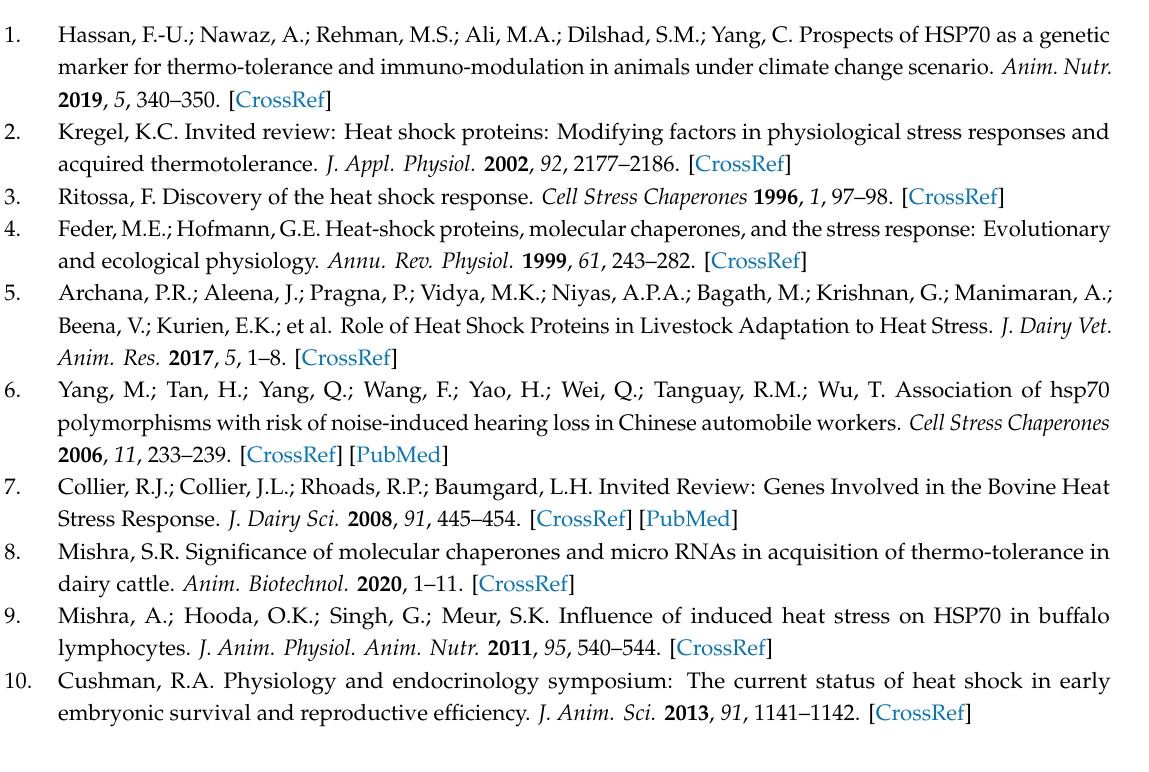
Figure S1: Tree with alignment view of HSP40 . Percentage of sequence is represented with di ff erent colors in Identity bar at top of the sequences green color indicates 100% identity, green-brown shows at least 30 and under 100% while red representing below 30 identity. Figure S2: Tree with alignment view of HSP70 . Percentage of sequence is represented with di ff erent colors in Identity bar at top of the sequences green color indicates 100% identity, green-brown shows at least 30 and under 100% while red representing below 30 identity. Figure S3: Tree with alignment view of HSP90 . Percentage of sequence is represented with di ff erent colors in Identity bar at top of the sequences green color indicates 100% identity, green-brown shows at least 30 and under 100% while red representing below 30 identity. Figure S4: Tree with alignment view of HSPD . Percentage of sequence is represented with di ff erent colors in Identity bar at top of the sequences green color indicates 100% identity, green-brown shows at least 30 and under 100% while red representing below 30 identity. Figure S5: Tree with alignment view of HSP10 . Percentage of sequence is represented with di ff erent colors in Identity bar at top of the sequences green color indicates 100% identity, green-brown shows at least 30 and under 100% while red representing below 30 identity. Figure S6: Tree with alignment view of HSPH1 . Percentage of sequence is represented with di ff erent colors in Identity bar at top of the sequences green color indicates 100% identity, green-brown shows at least 30 and under 100% while red representing below 30 identity. Figure S7: Tree with alignment view of HSPB . Percentage of sequence is represented with di ff erent colors in Identity bar at top of the sequences green color indicates 100% identity, green-brown shows at least 30 and under 100% while red representing below 30 identity. Table S1: Accession no. of di ff erent heat-shock protein in di ff erent organisms used in phylogenetic analysis, Table S2: Accession no. of bu ff alo HSP90 , Table S3: Accession no. of bu ff alo HSP70 , Table S4: Accession no. of bu ff alo HSP40, Table S5: Accession no. of bu ff alo HSP family B , HSP10 , HSPD , and HSPH1 , Table S6: Mutations in coding region of HSP gene family in bu ff